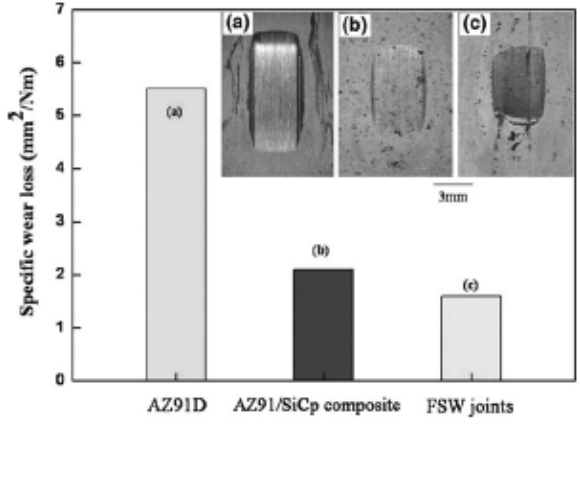
Figure 11 . Wear loss of AZ91, SiC/AZ91 composite without and with FSP (after Lee et al.